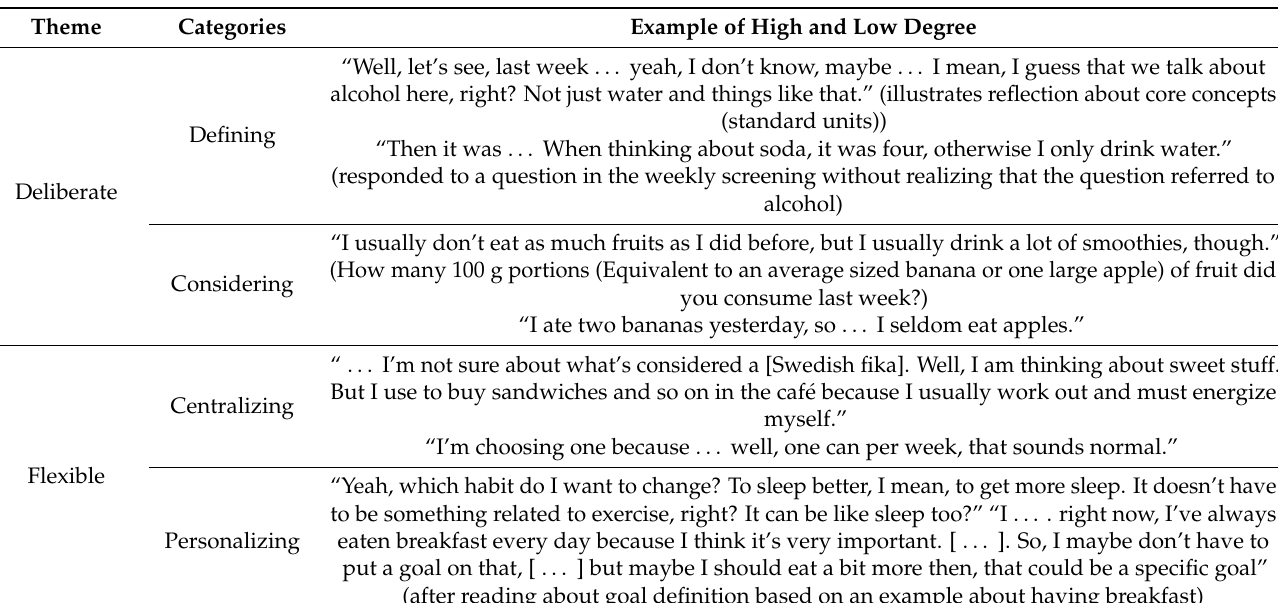
Table 3. Illustration of how themes and categories are derived from data.